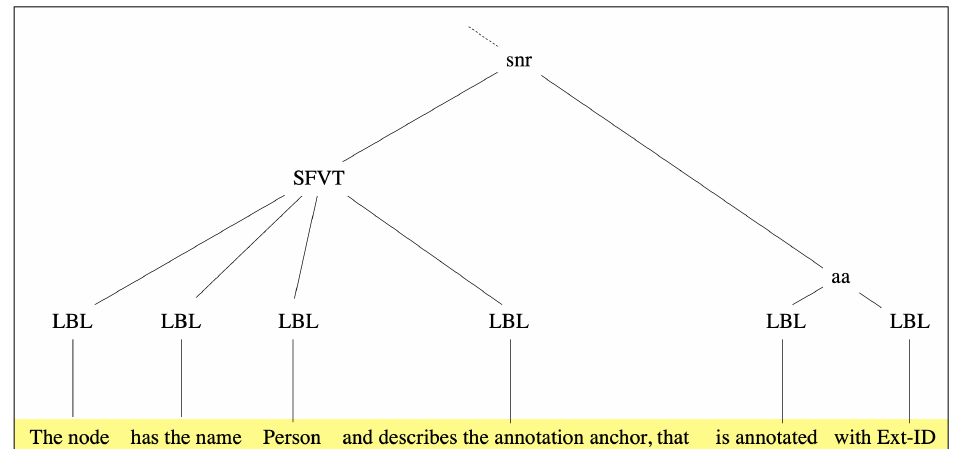
Figure 9. Snippet of the PS-tree with production rules, P ESMMFG , of G ESMMFG , applied to SMMFG ex , including semantic feature vocabulary